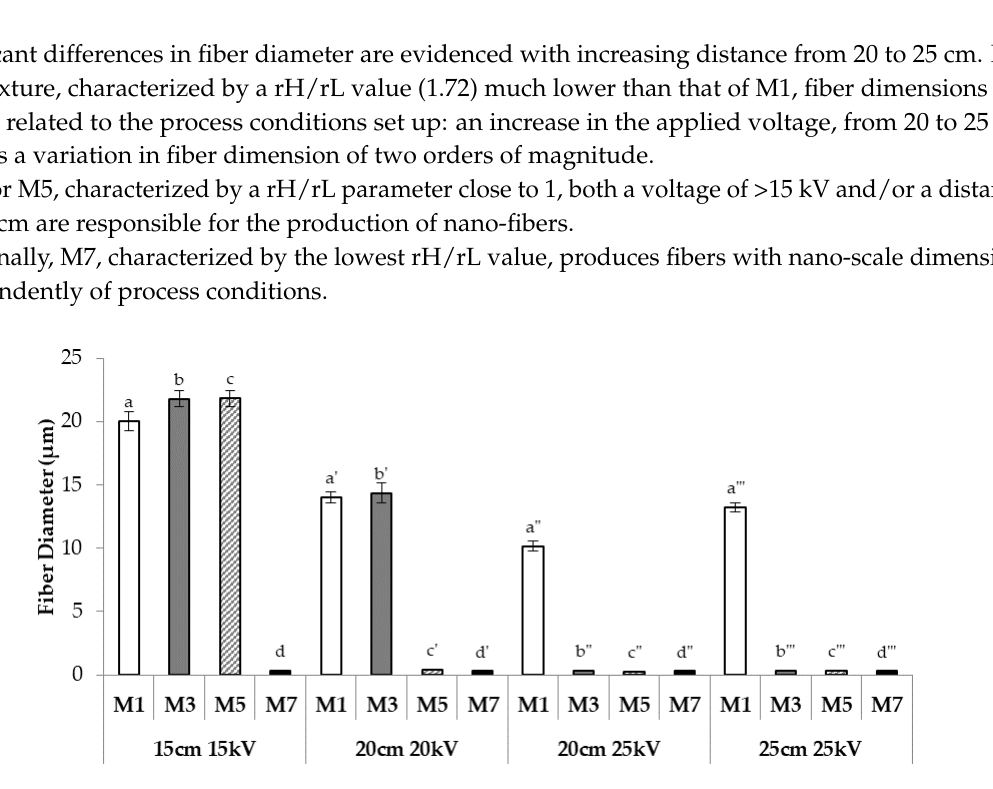
Figure 9. Dimensions of fibers obtained from M1, M3, M5, and M7 when electrospun under four different process conditions in terms of spinneret–collector distance and applied voltage (mean values ± SE; n = 30); one-way ANOVA; Multiple Range Test ( p < 0.05): a vs a’–a’’’, a’ vs a’’, a’’ vs a’’’; b vs b’–b’’’, b’ vs b’’, b’’’; c vs c’–c’’’; d vs d’–d’’’.